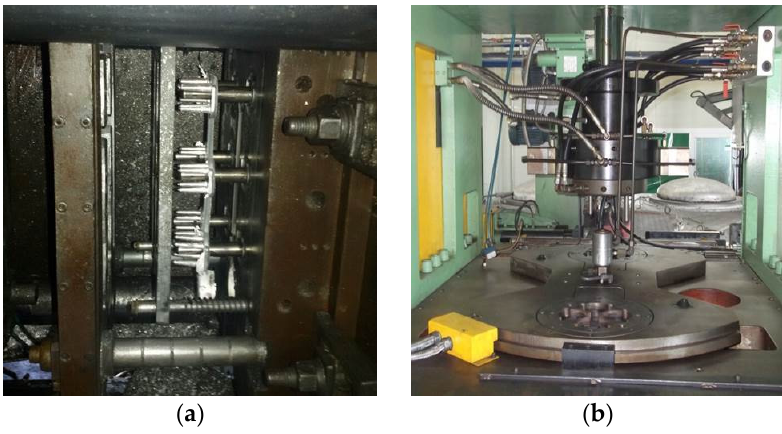
Figure 1. Pressure die ‐ casting method. ( a ) Horizontal type; ( b ) Vertical type.